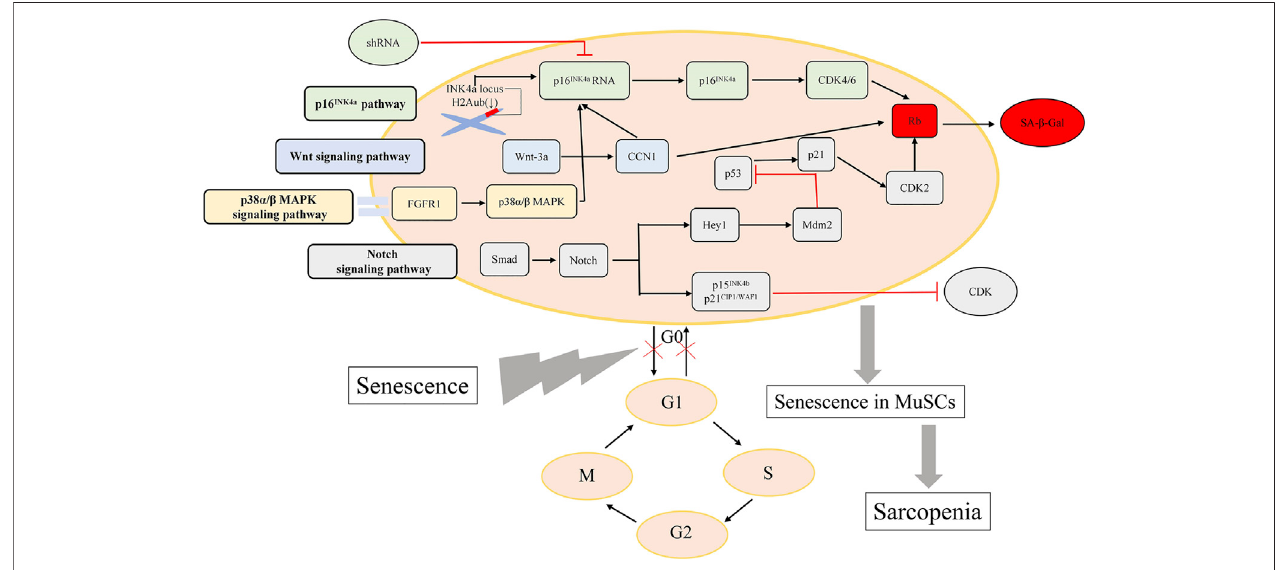
FIGURE 1 | Major pathways regulating MuSCs dysfunction. The vital signaling pathways in fl uencing the capacity of MuSCs regeneration are presented here.